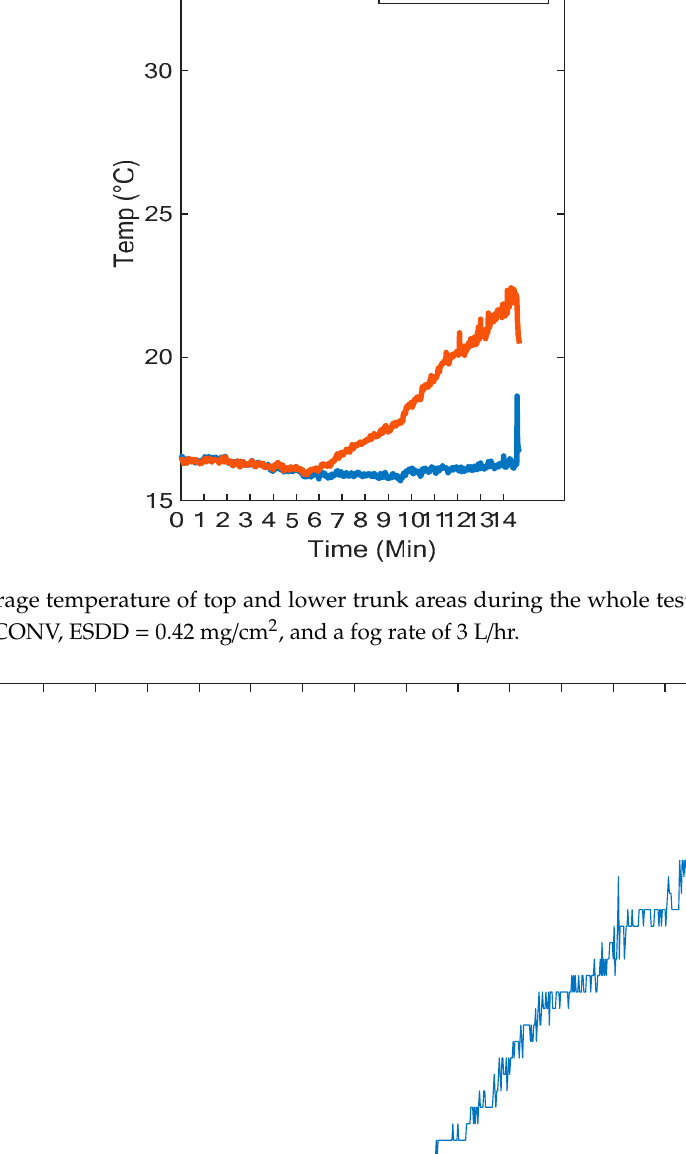
Figure A1. Average temperature of the main trunk areas during the whole test (left and right zones). Design CONV, ESDD = 0.42 mg/cm 2 , and a fog rate of 3 L/hr.